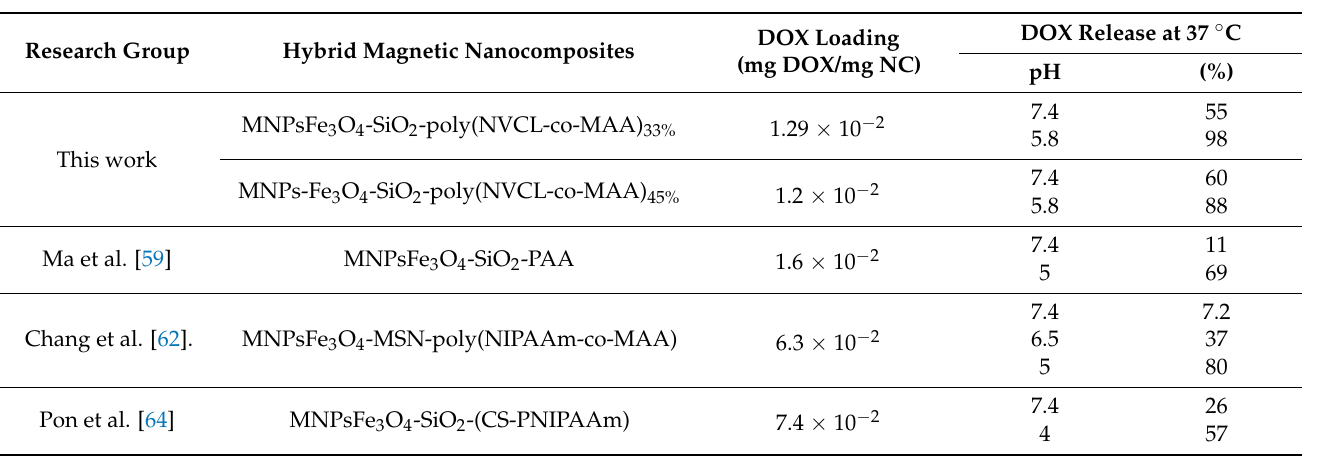
Table 1. Comparison of DOX loading and DOX release of hybrid magnetic nanocomposites reported by other research groups.